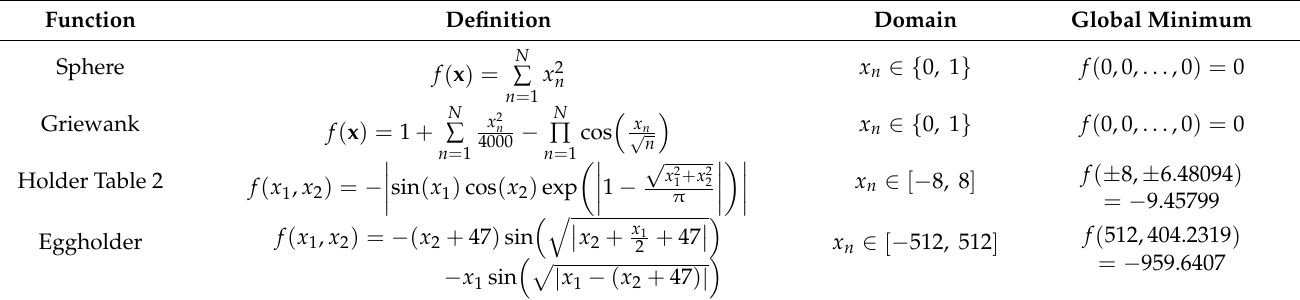
Table 1. Mathematical definitions of functions used to test a set of BPSO